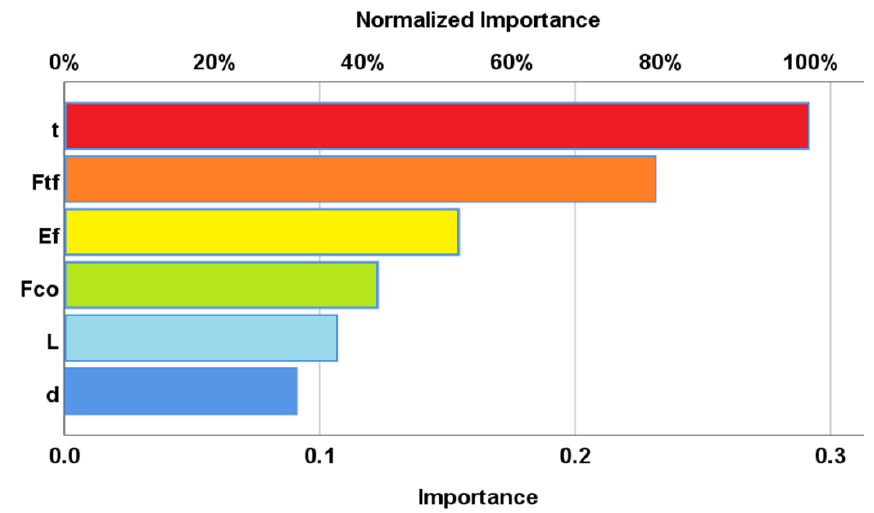
Figure 4. Relative importance of input parameters.